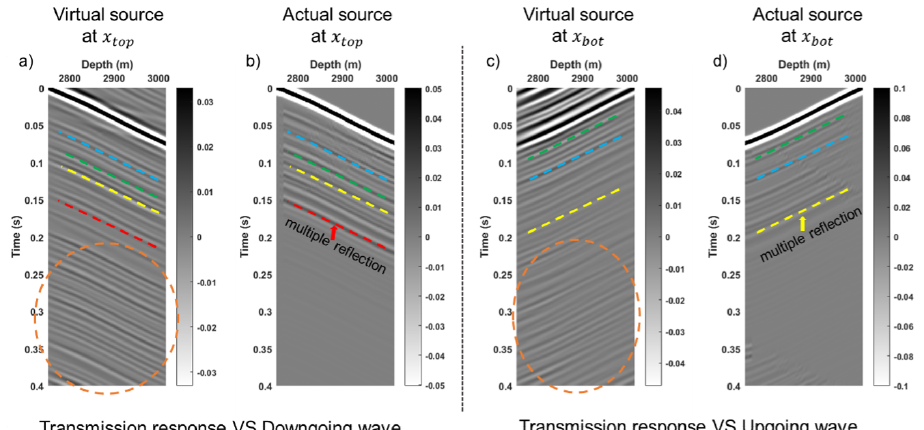
Figure 12. Transmission response estimation using synthetic shot data. ( a , c ) show the transmission response with a virtual source at the top and bottom geophone. ( b ) The downgoing wave from an actual source at the top geophone. ( d ) Upgoing wave from an actual source at the bottom geophone. Colored dashed lines represent events in the interferometry result that match with the up- or downgoing events from the model. Dashed circle shows artifacts of spurious